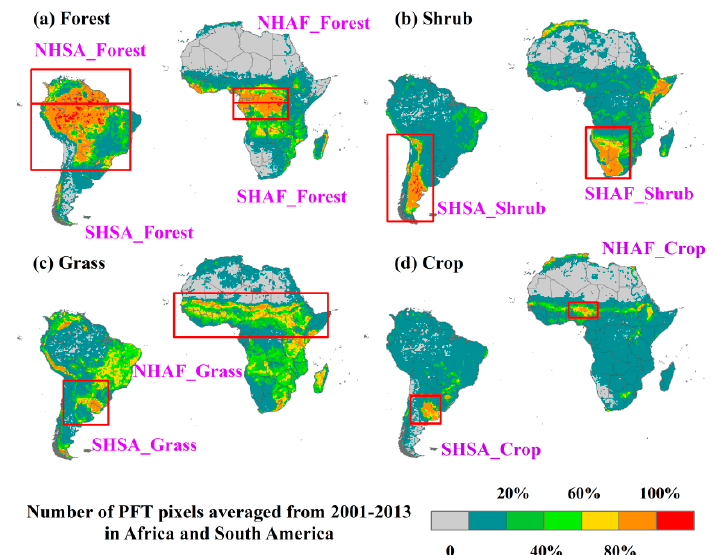
Figure 1. The mean annual land cover map and the high-density vegetated regions (defined as an individual vegetation type occupying more than 80% of the 0.5 ◦ × 0.5 ◦ grid cell) for ( a ) forest, ( b ) shrub, ( c ) grass, and ( d ) crop in Africa and South America. Specific regions (red rectangles) were defined as follows: Forest in the Northern Hemisphere in Africa (NHAF_Forest), Forest in the Southern Hemisphere in Africa (SHAF_Forest), Forest in the Northern Hemisphere in South America (NHSA_Forest), and Forest in the Southern Hemisphere in South America (SHSA_Forest). Shrub in the Southern Hemisphere in Africa (SHAF_Shrub) and Shrub in the Southern Hemisphere in South America (SHSA_Shrub). Grass in the Northern Hemisphere in Africa (NHAF_Grass) and Grass in the Southern Hemisphere in South America (SHSA_Grass). Crop in the Northern Hemisphere in Africa (NHAF_Crop) and Crop in the Southern Hemisphere in South America (SHSA_Crop). The division between SHAF_Forest and NHAF_Forest is at the equator; the division between SHSA_Forest and NHSA_Forest is at the